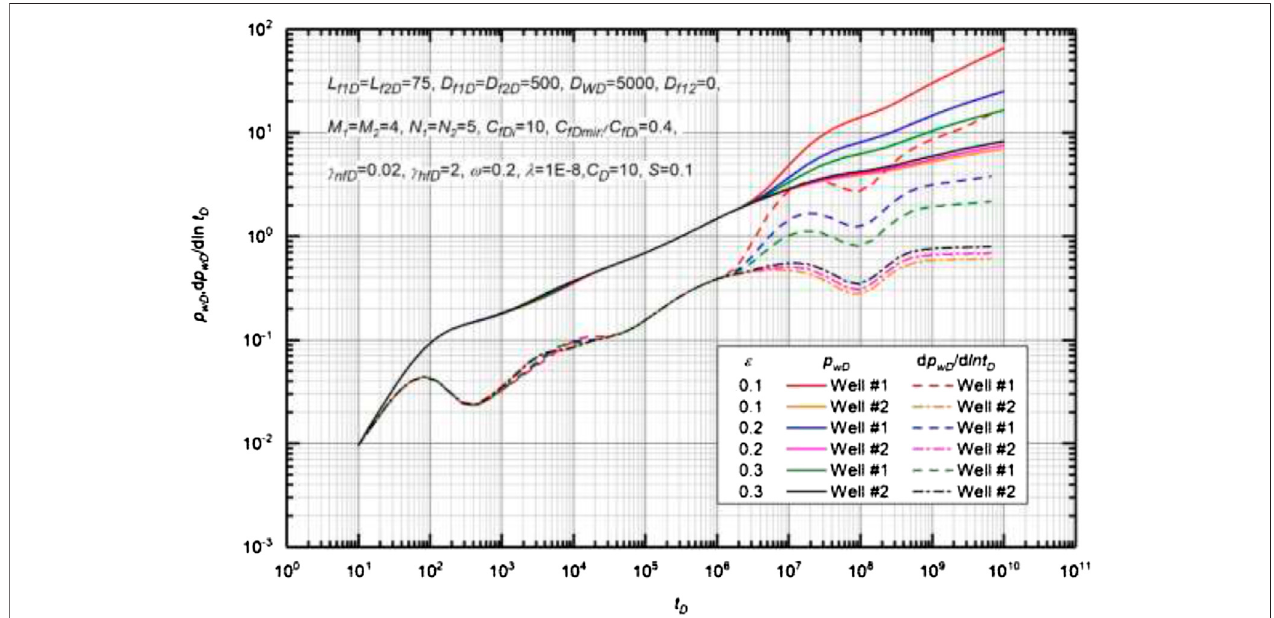
FIGURE 7 | Effect of well rate ratio on the transient pressure for multi-well pad with multiple fractures (MWPMF).